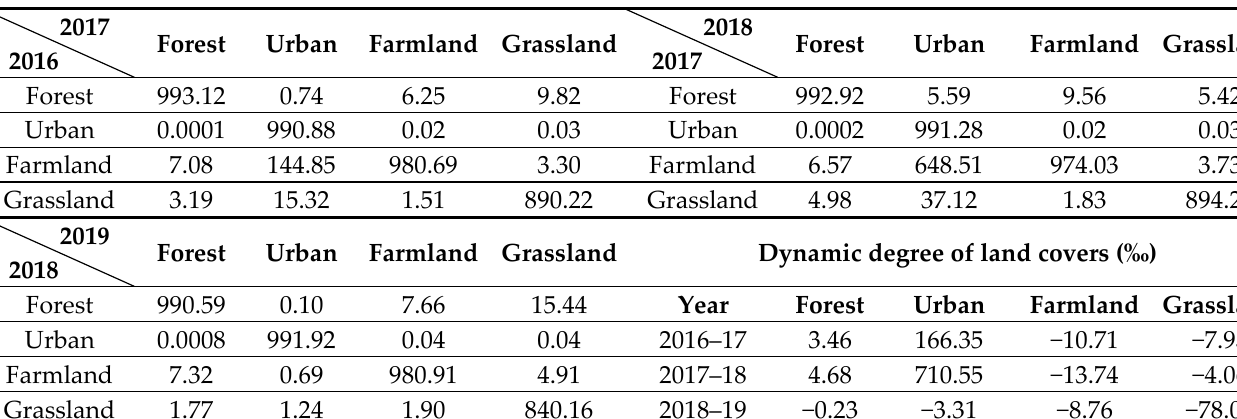
Table 2. Dynamic degree of land covers and transition between urban, farmland, forest and grassland from 2016 to 2019 (unit: ‰). In the transition from 2016 to 2019, the number represents the proportion of transition area to total area of the specific land cover in the former year. Dynamic degree reflects the change rate of land area during the years, which is influenced by all other land cover classes.